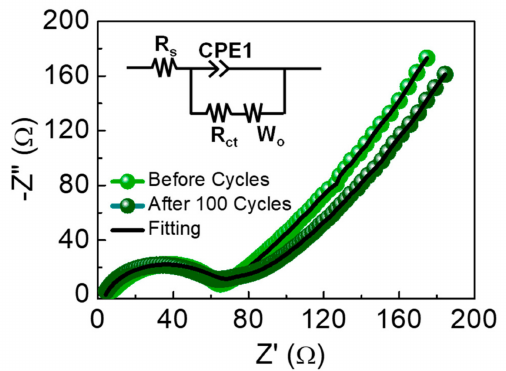
Figure 6. Nyquist plots before and after 100 charge–discharge cycles at J a = 0.1 A / g and the equivalent circuit (inset) for the LIB device with the anode material of IMP-GC nanoflakes.